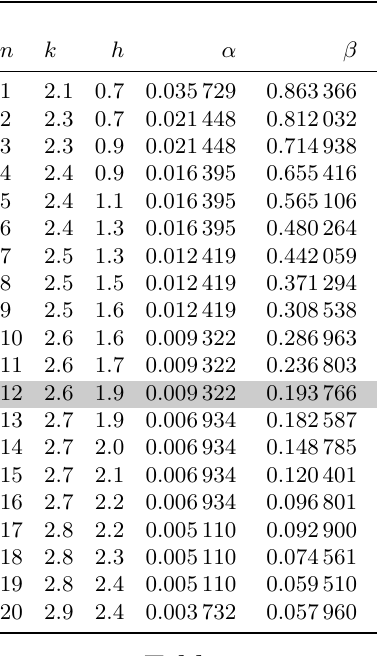
Table 1: Optimal economic design of the ¯ X -control